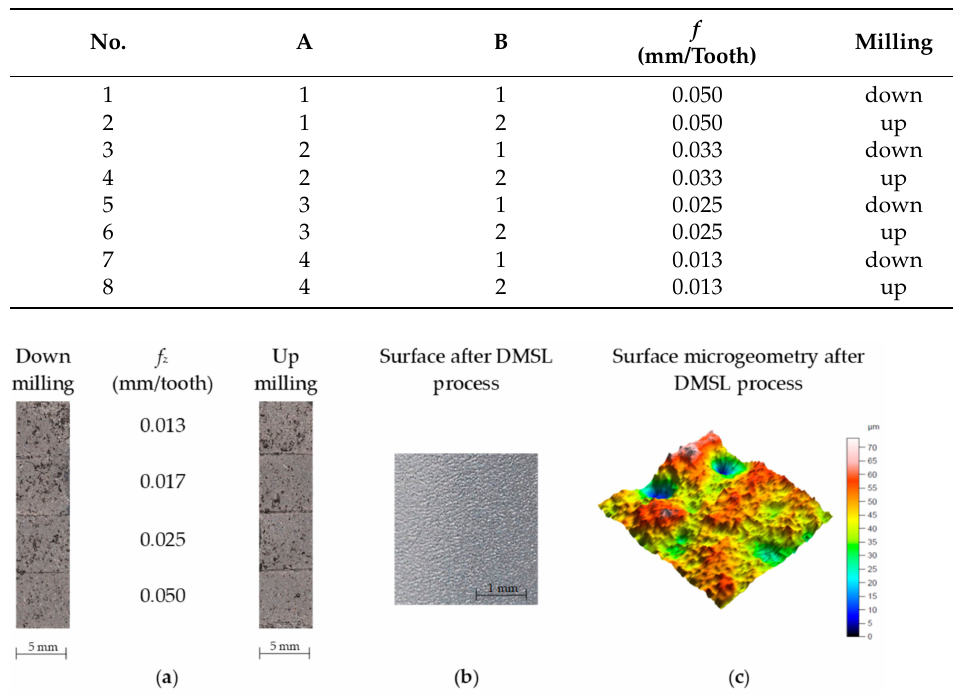
Table 1. Research plan with real values.